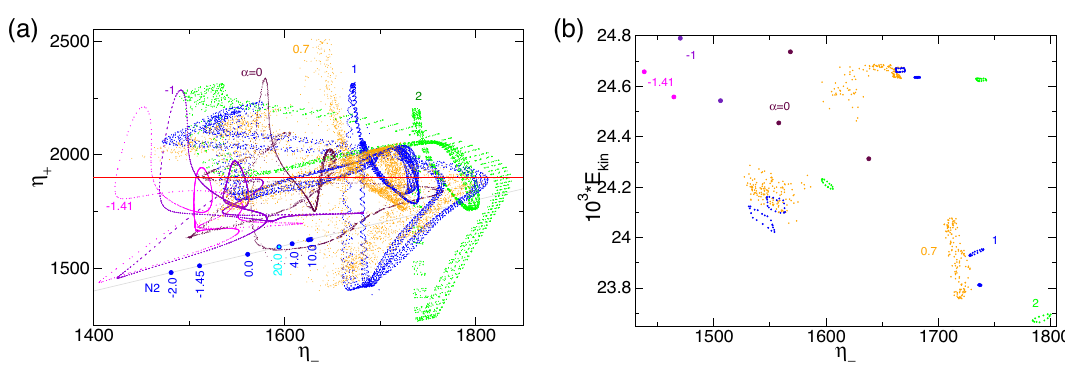
Figure 16. ( a ) Phase portraits of pV 1 , pV 2 and pV 3 states for α as indicated on (η corresponding two-dimensional Poincaré sections, ( E kin , η Numbers in the figure identify the radial flow, α . The thin gray line in ( a ) indicates the diagonal η which all Z 2 symmetric solutions (i.e., N2) can be found.